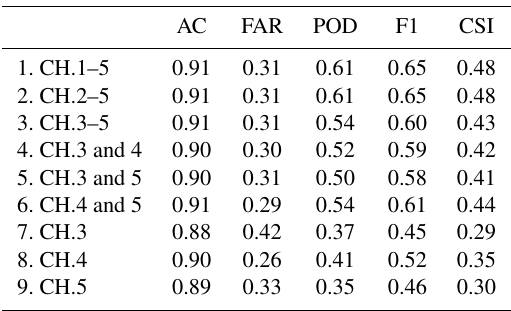
Table 2. Errors in cloud filtering using different channels.